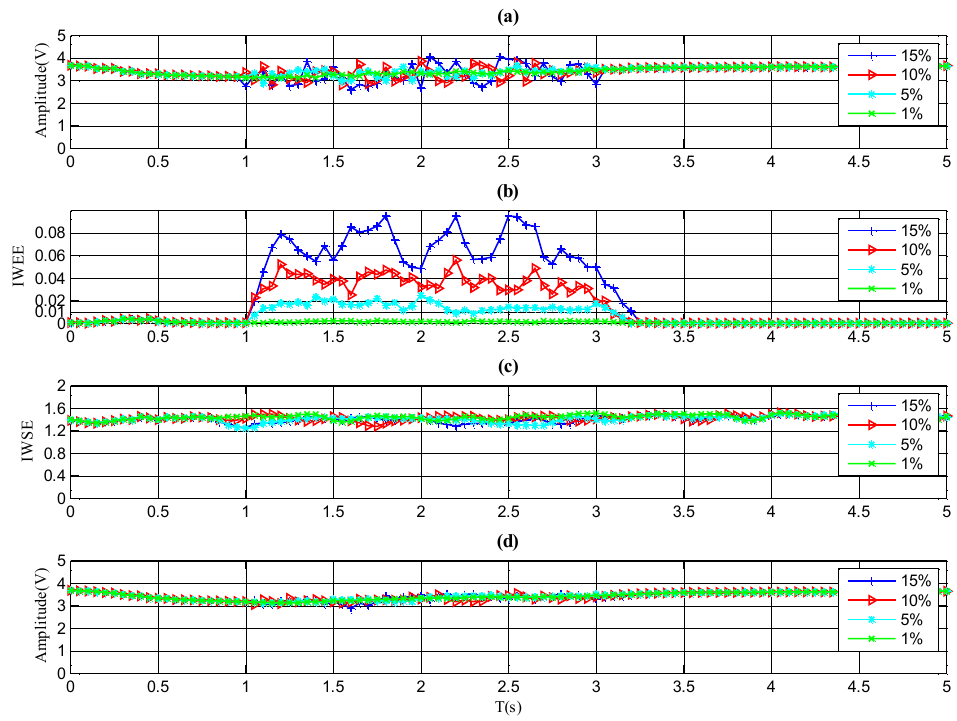
of the signal. mean